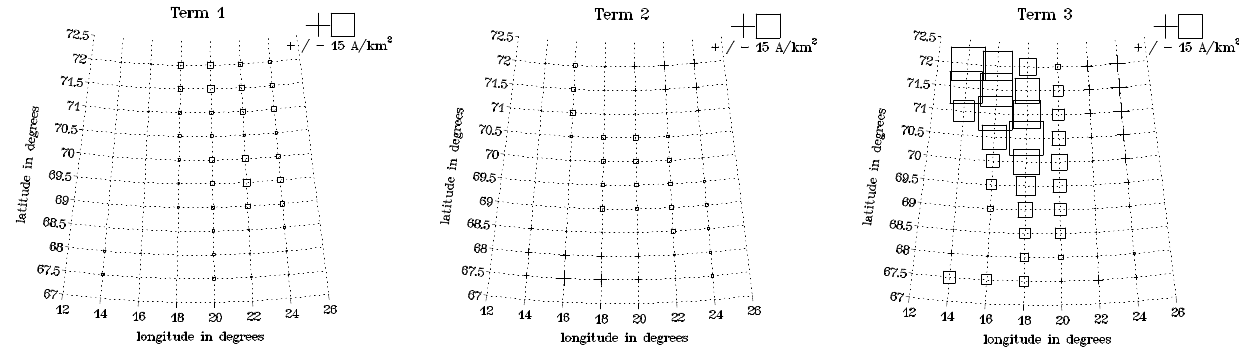
Fig. 8. Decomposition of the total FAC density j || at 03:23 UT into a term related to the divergences of the electric field (left panel), a term related to the gradients of the Pedersen conductance (middle panel), and a term related to the gradients of the Hall conductance (right panel); crosses denote downward, squares upward currents; for more details see